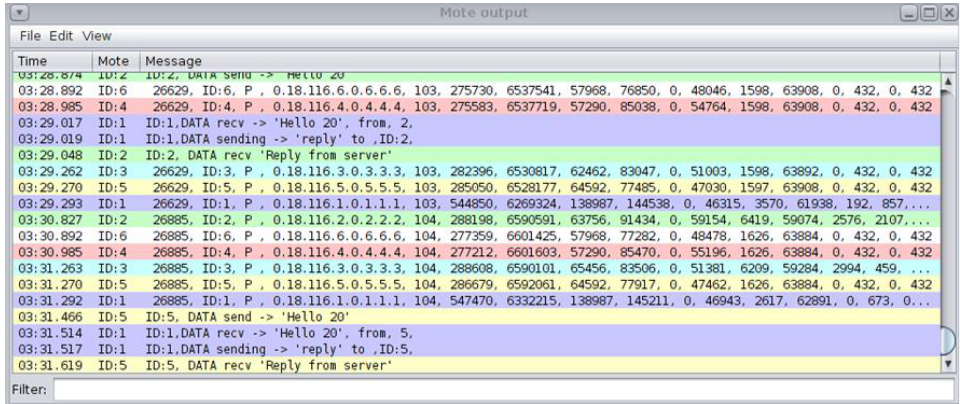
Figure 6 . Cooja Simulator — Mote output window. Figure 6. Cooja Simulator—Mote output